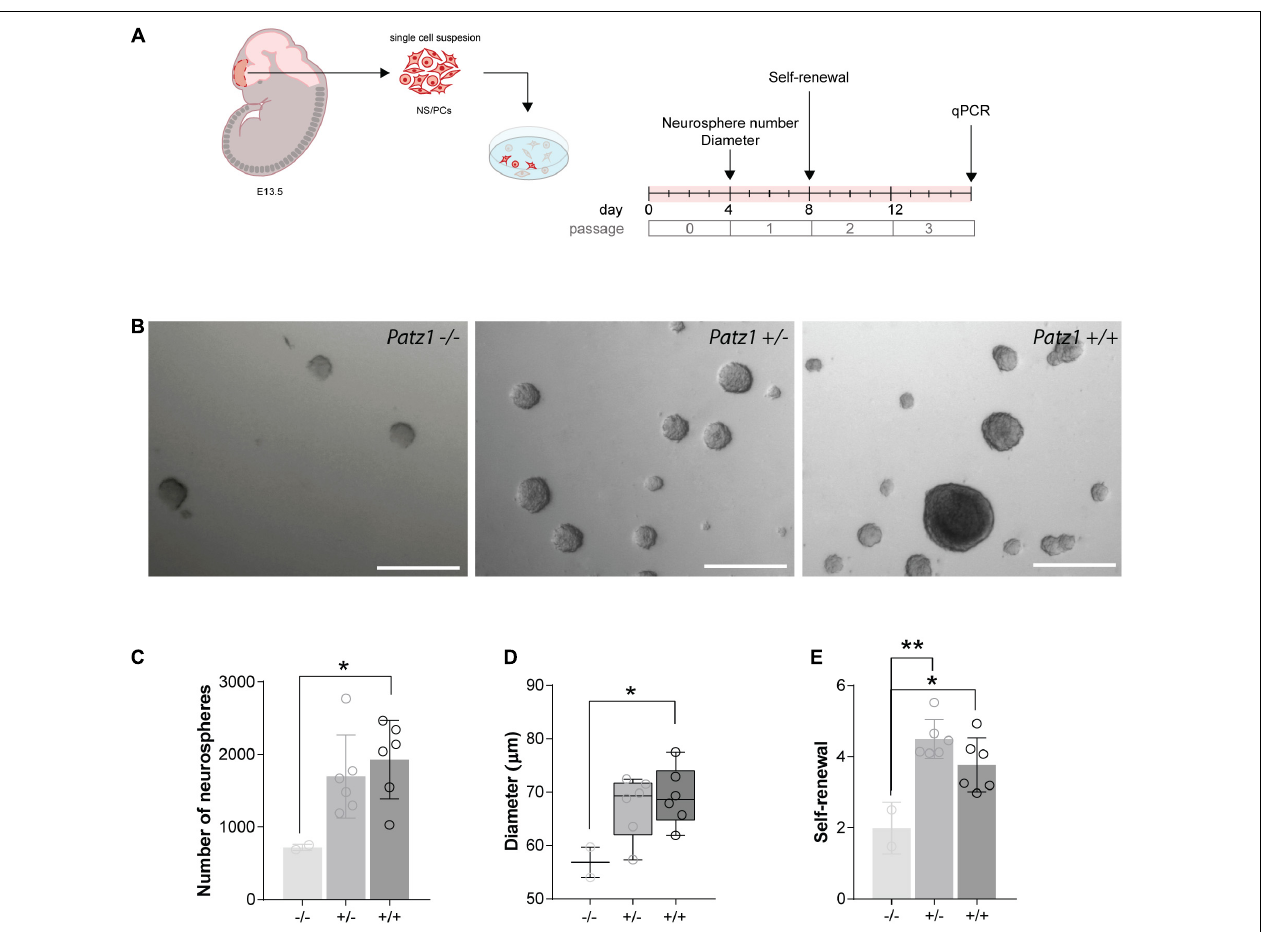
FIGURE 4 | Ex vivo proliferation assay of 13.5 dpc embryonic telencephalon-derived neurospheres. (A) Experimental scheme showing the brain region microdissected to produce neurospheres, and relative experiment timeline. (B) Representative images of neurospheres from Patz1 − / − , Patz1 + / − and wild type embryos. Scale bars = 100 µ m. (C) Bar/dot plot (means ± SD) showing the number of primary neurospheres (P0) obtained by plating 1 × 10 5 cells/embryo obtained from the dissected tissue. (D) Box dot/plot showing the diameter of P0 neurospheres (median ± min to max). (E) Neurosphere self-renewal capacity (number of neurospheres of the first-generation (P1)/plated cells * 100). All the significant differences are indicated by asterisks. * P < 0.05; ** P < 0.01, as assessed by ANOVA followed by Tukey’s multiple comparisons